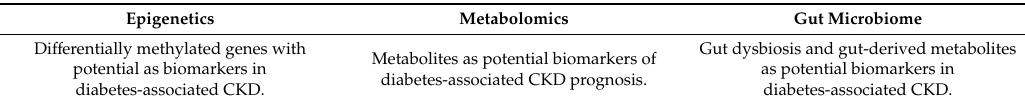
Table 1. Summary of Potential Novel Biomarkers in Epigenetics, Metabolomics, and the Gut Microbiome Discussed in this